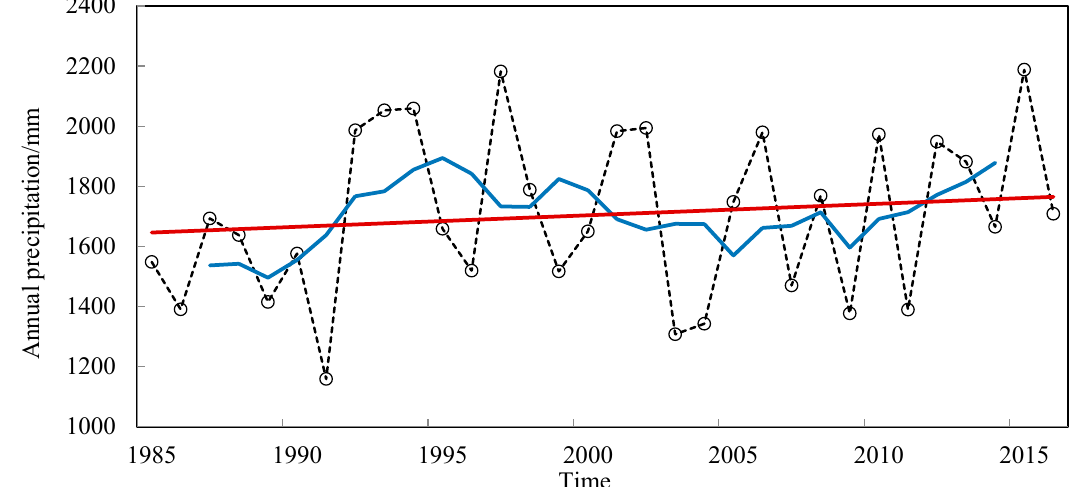
Figure 2. Annual precipitation over the BJR: the black dotted line with circles represents the precipitation over the whole area, the blue line indicates the five-year moving average, and the red line represents the linear trend. Table 1. Annual precipitation of the meteorological stations.